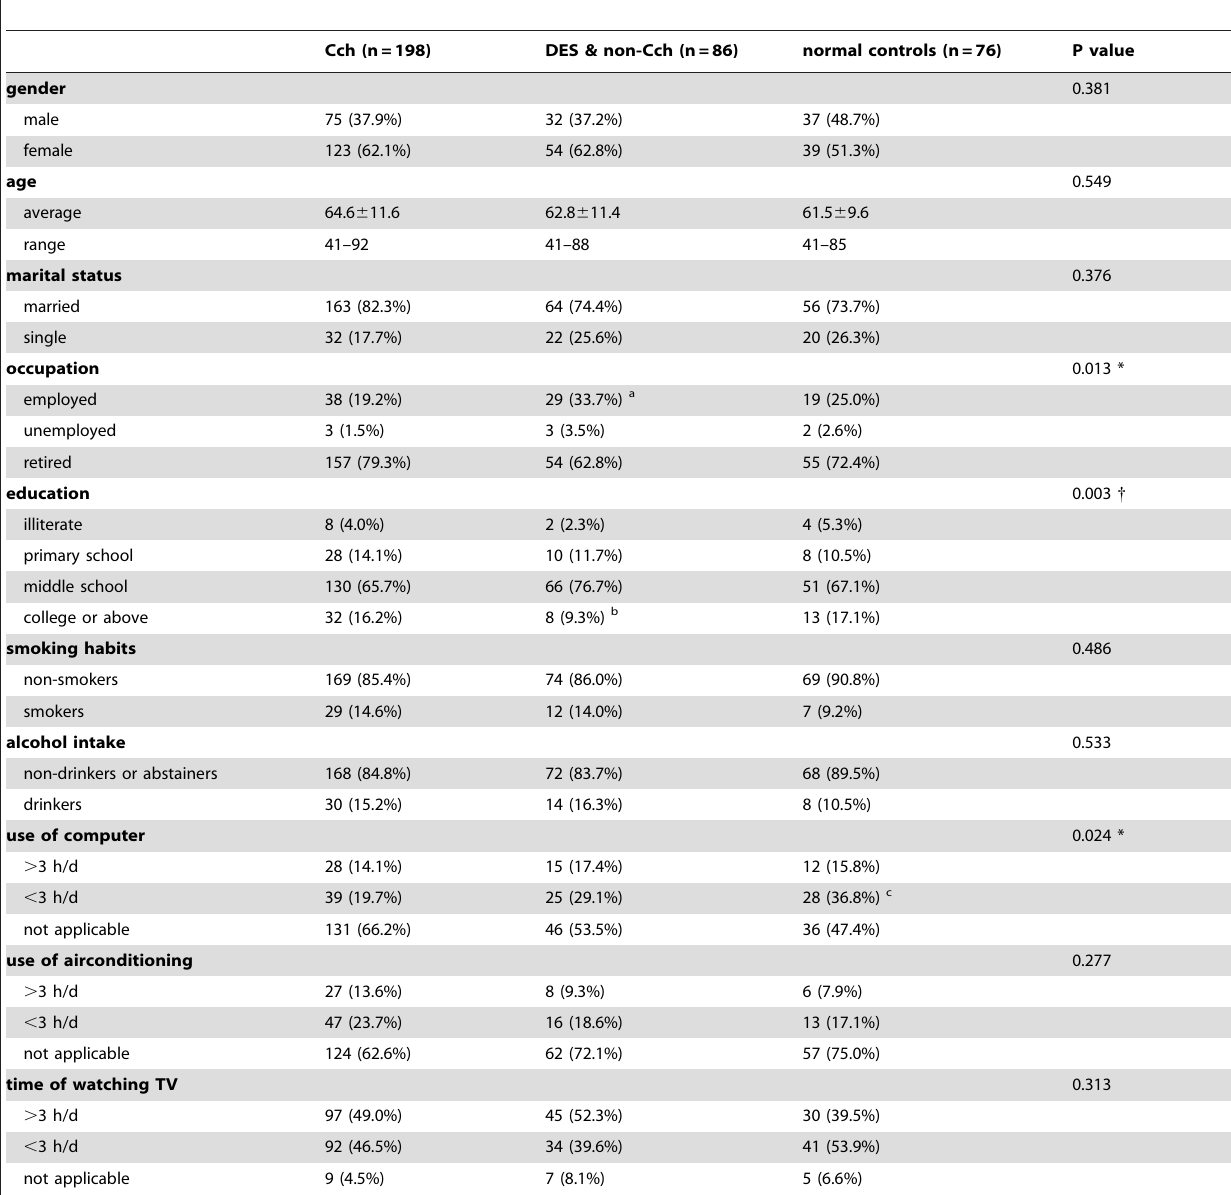
Table 2. Socio-demographic data of enrolled